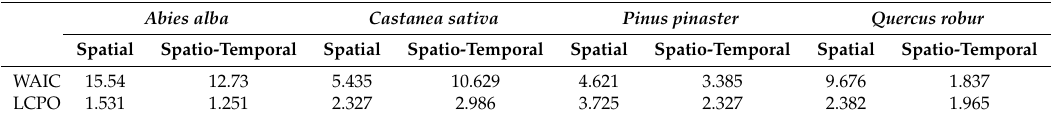
Table 3. Watanabe-Akaike information criterion ( WAIC) and logarithmic score of conditional predictive ordinate (LCPO) comparison in species models. Abies alba Castanea sativa Pinus pinaster Quercus robur Spatial Spatio-Temporal Spatial Spatio-Temporal Spatial Spatio-Temporal Spatial